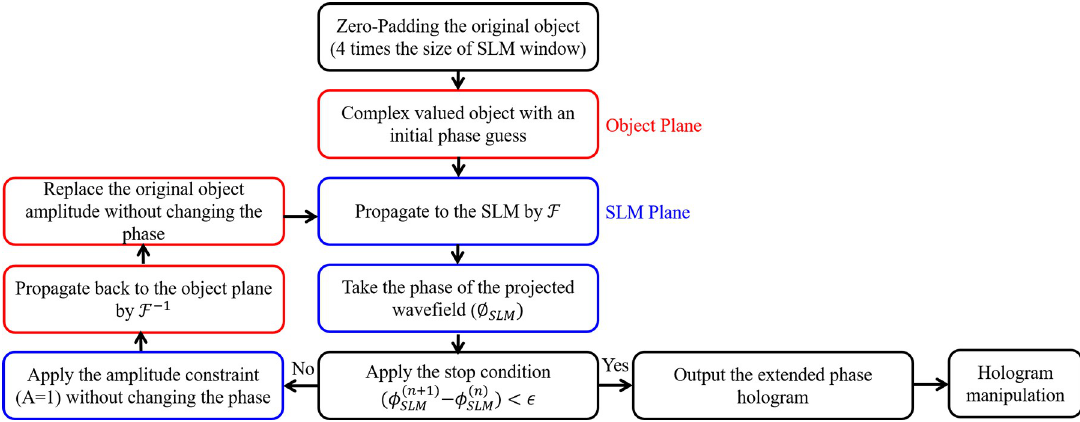
Fig 5. Flowchart of the iterative Fourier transform algorithm (IFTA) where F and F (cid:0) 1 denote fast Fourier transform and inverse fast Fourier transform, ; is the phase of the wavefield at the SLM plane, and n is the iteration SLM